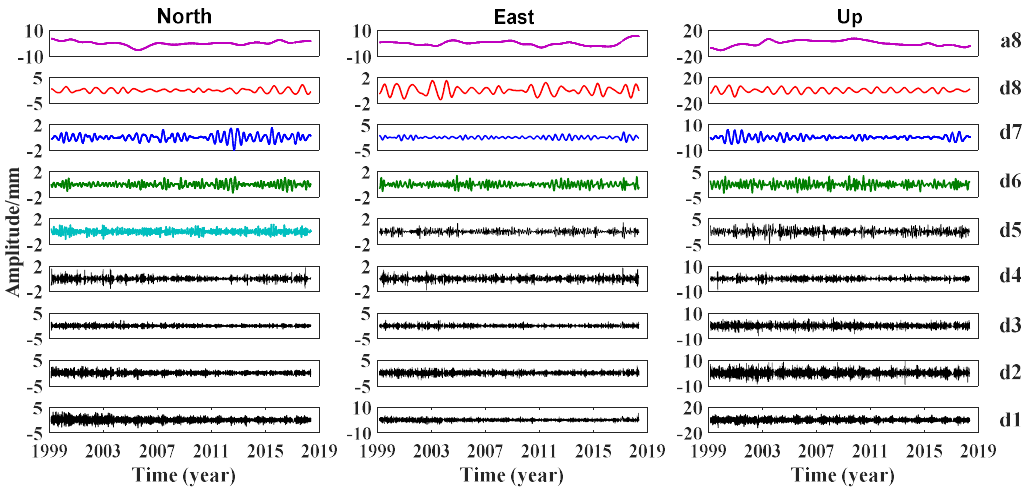
Figure 5. Formal errors of BJFS station.